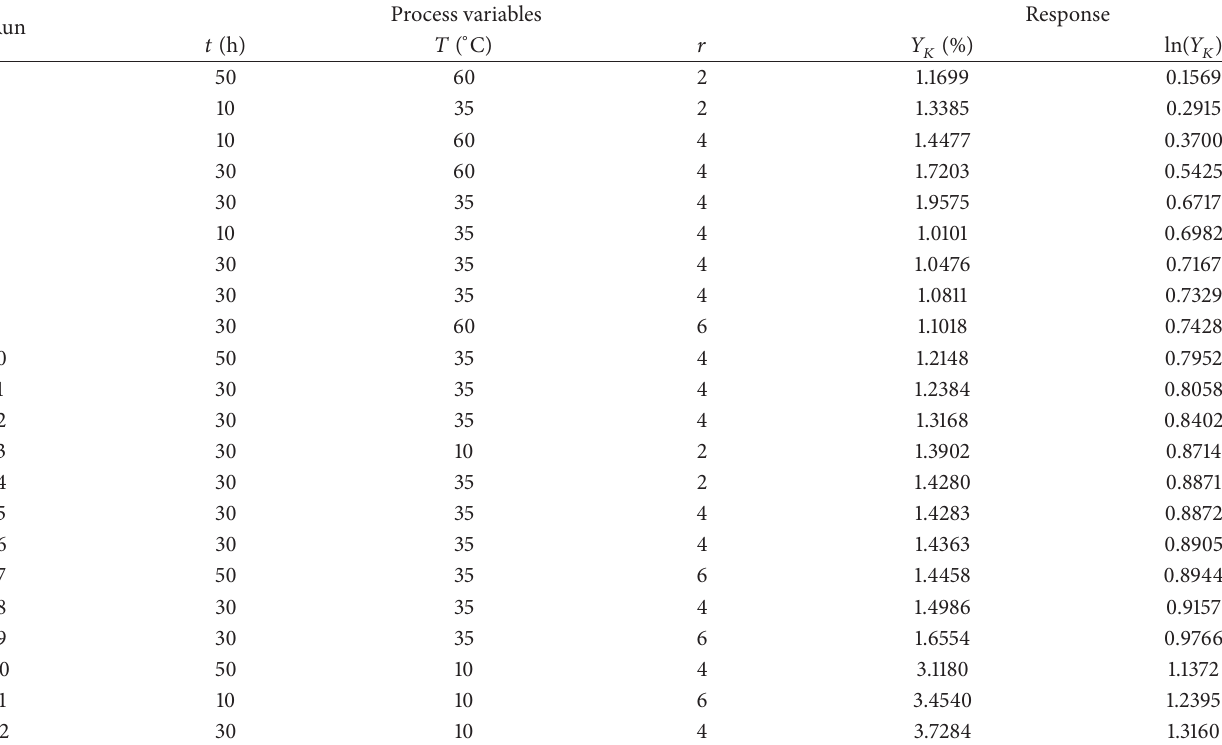
Table 2: Sorted CCD and response data for liquid-liquid extraction of spent lubricant with ketone (methyl ethyl ketone).